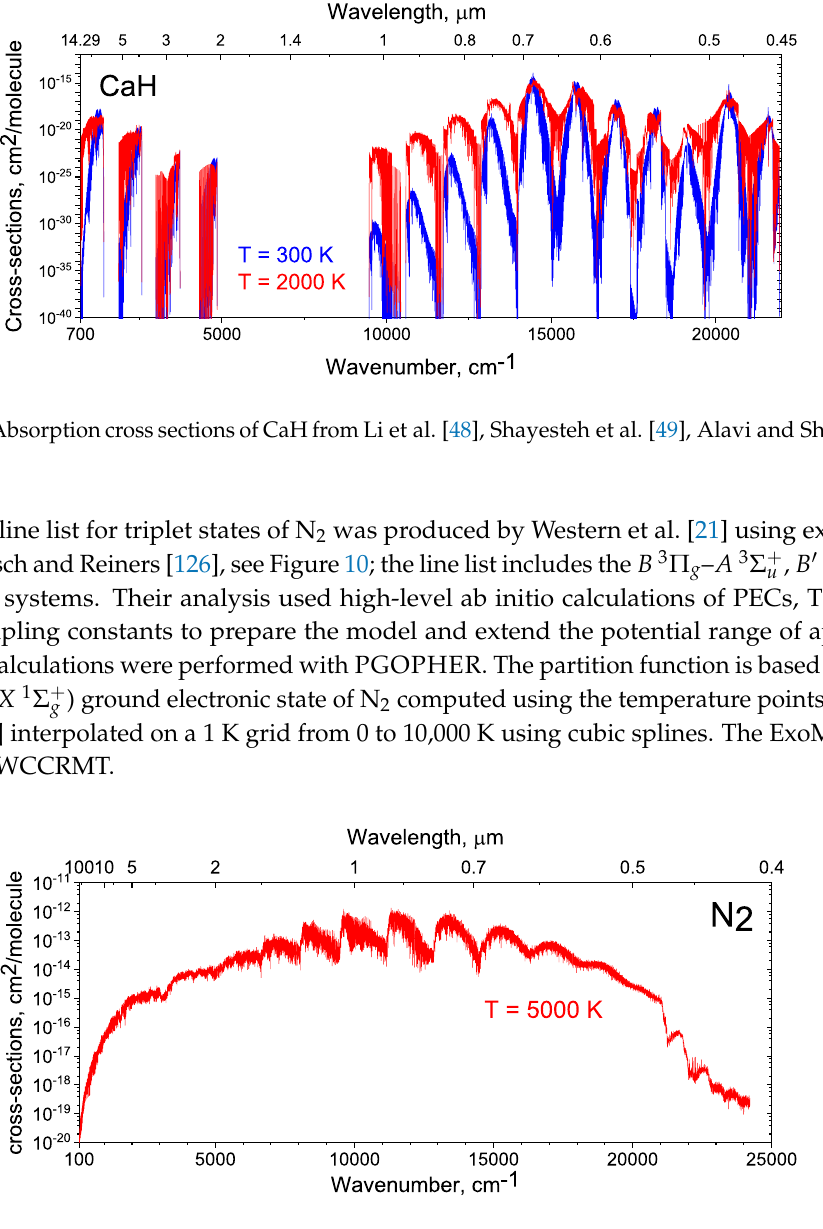
Figure 10. Line lists for N 2 from Western et al.